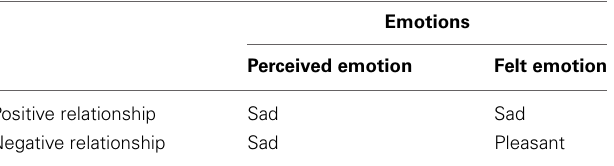
Table 1 | Relationships between perceived and felt